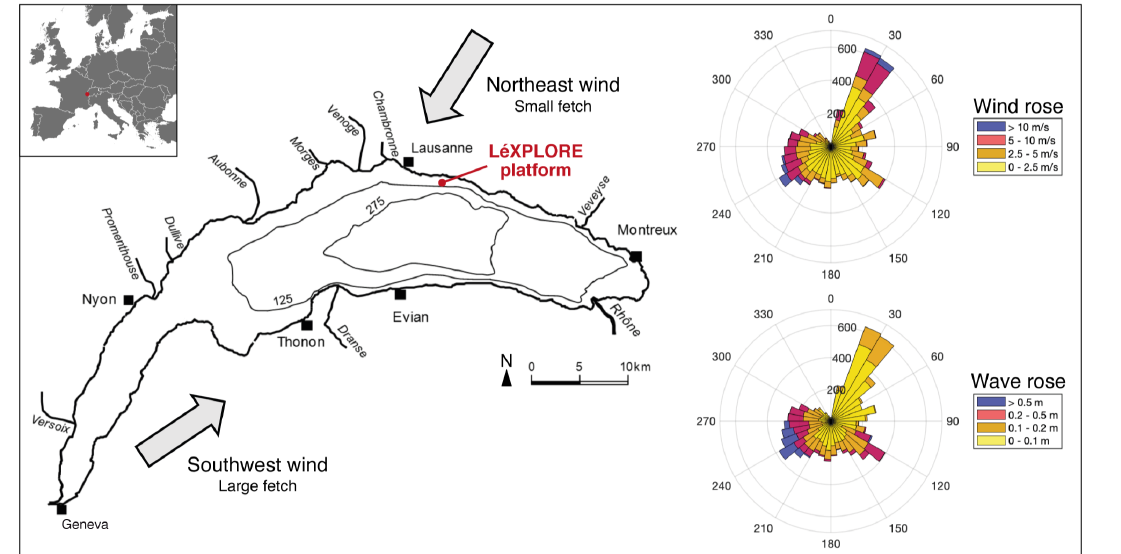
Figure 2. Location and map of Lake Geneva with the two prevailing winds (left) also depicted by the wind rose (top right). The wave rose highlights the highest wave field generated at the sampling location by the southwest wind with a larger fetch (bottom right). Both the wind and wave roses are computed with annual data from 13 June 2019 to 12 June 2020 at